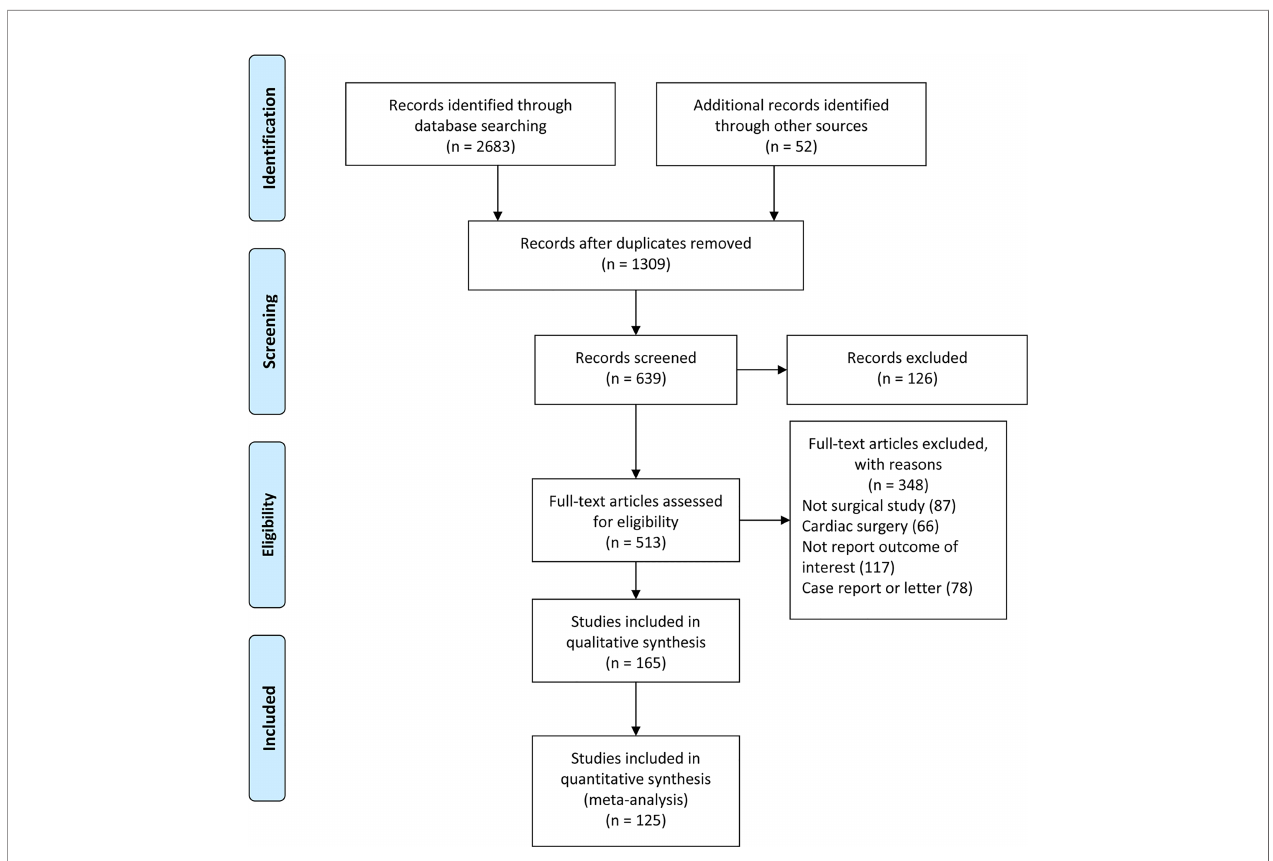
FIGURE 1 | Flowchart of study